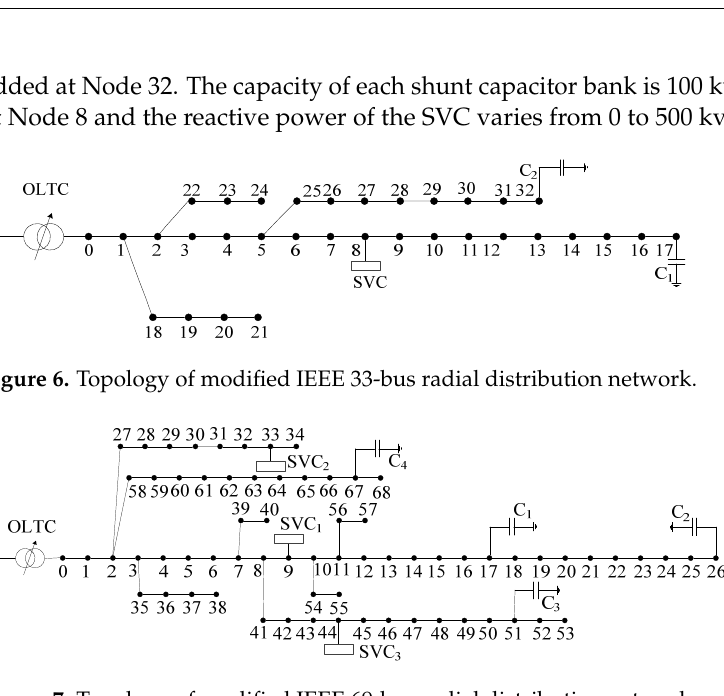
Figure 7. Topology of modified IEEE 69-bus radial distribution network.